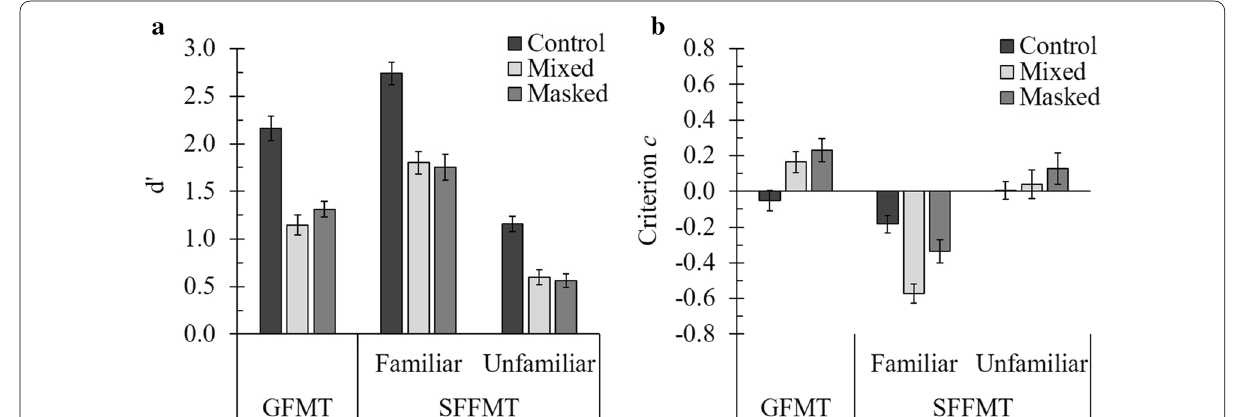
*Identifies statistically significant t tests